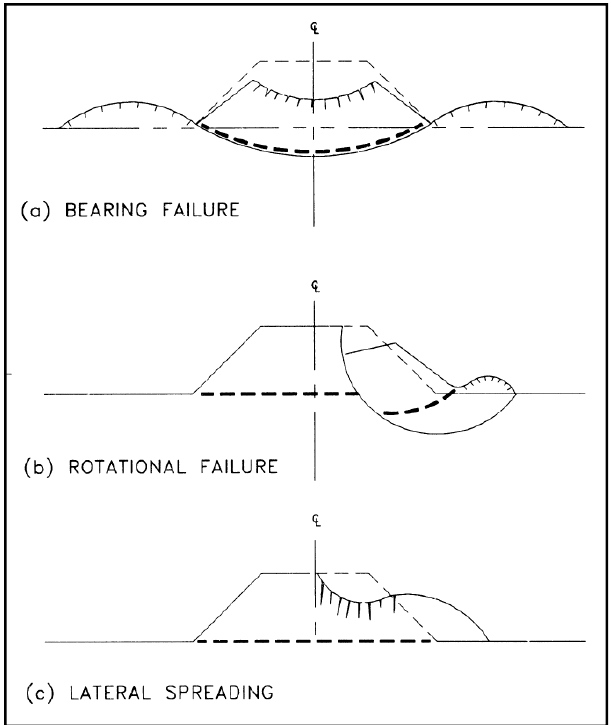
Figure 2. Embankment Failure Modes on Weak Foundation Soils [29].